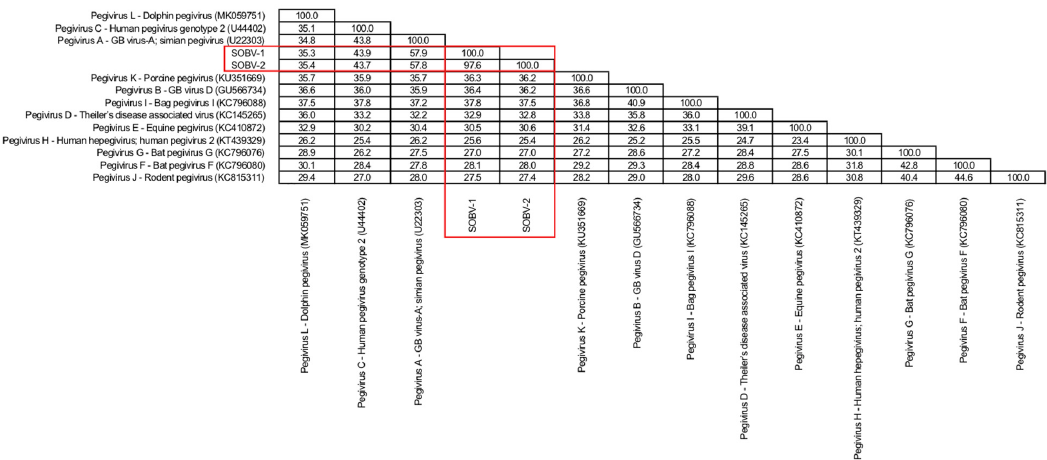
Figure 2. Sliding window similarity plots [79] show the relatedness of the amino acid sequences of SOBV-2 and other closely related pegiviruses to SOBV-1. Dashed vertical lines indicate the putative approximate start positions of inferred viral proteins, from left to right: E1, E2, P7, NS2, NS3, NS4A, NS4B, NS5A, and NS5B [80]. Abbreviations: SPgV-A nigri = GBV-A-like virus recovered from black-mantled tamarins ( Saguinus nigricollis ); SPgV-A tri = GBV-A-like virus recovered from three-striped night monkeys ( Aotus trivirgatus ); SPgV-A mx = GBV-A-like virus recovered from mustached tamarins ( S. mystax ); SPgV-A lab = GBV-A-like virus recovered from white-lipped tamarins ( S. labiatus ); BPgV 737 = bat pegivirus recovered from African straw-colored fruit bats ( Eidolon helvum ).